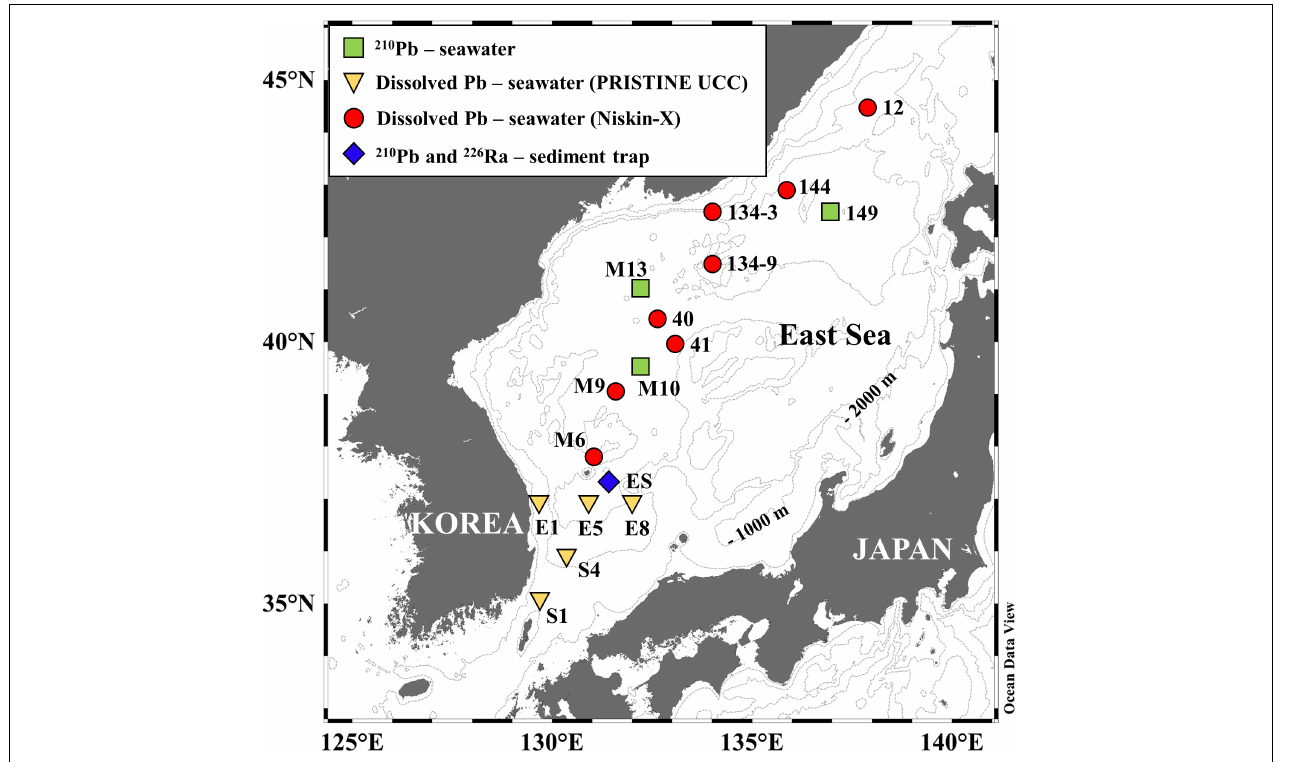
FIGURE 1 | Sampling locations for total 210 Pb and dissolved Pb in seawater and 210 Pb and 226 Ra in sinking